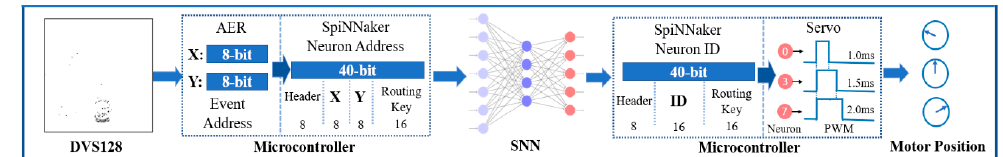
Figure 8. Workflow of the robotic system used for interception of a moving object.